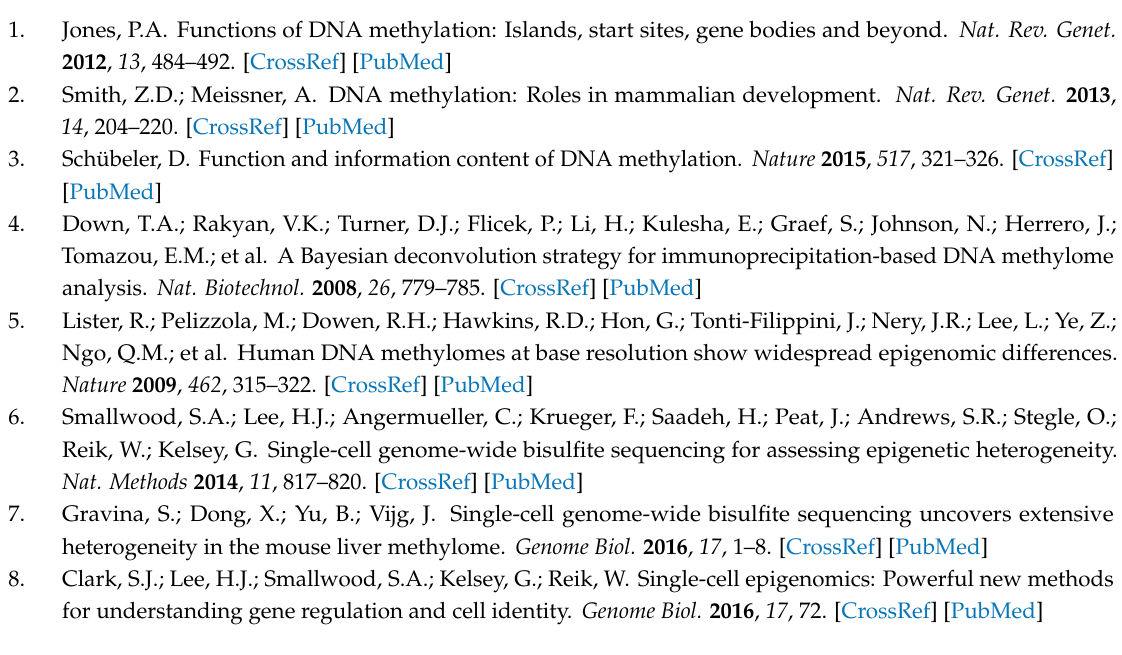
Table S1: Detected CpG islands with allele-specific methylation and associated